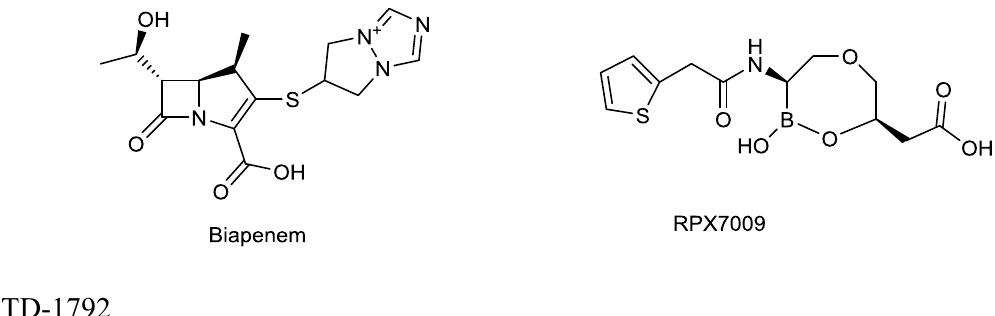
Figure 9. Chemical structures of Carbavance.